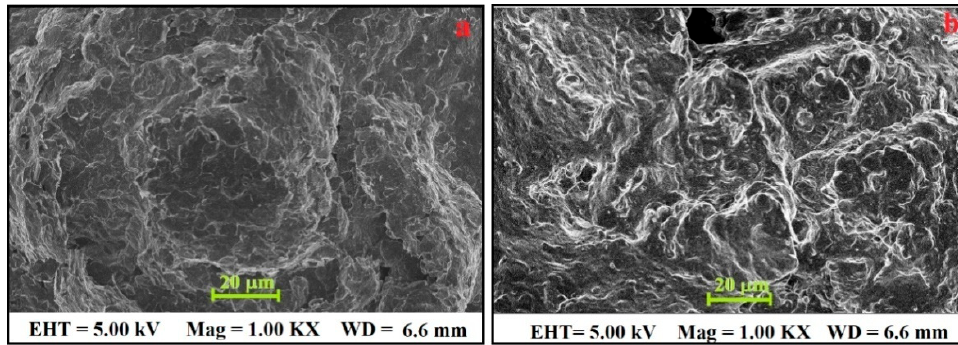
Figure 1. ( a ) FE-SEM picture of BGPE. ( b ) FE-SEM picture of PGAMGPE.